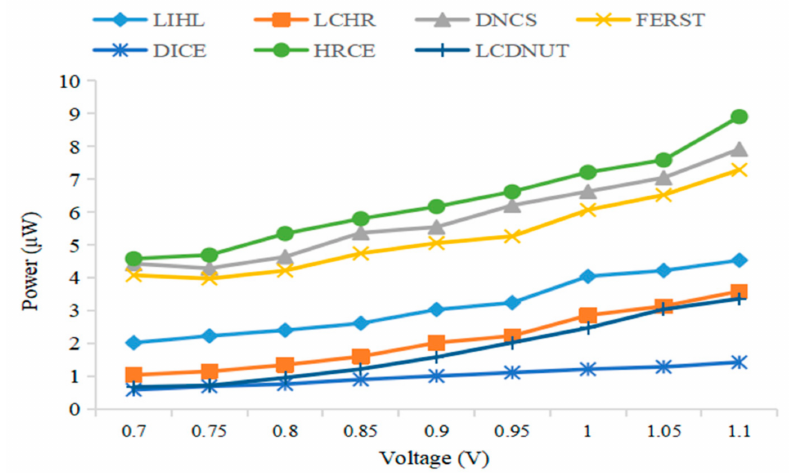
Figure 16. Power consumption of various latch designs under different